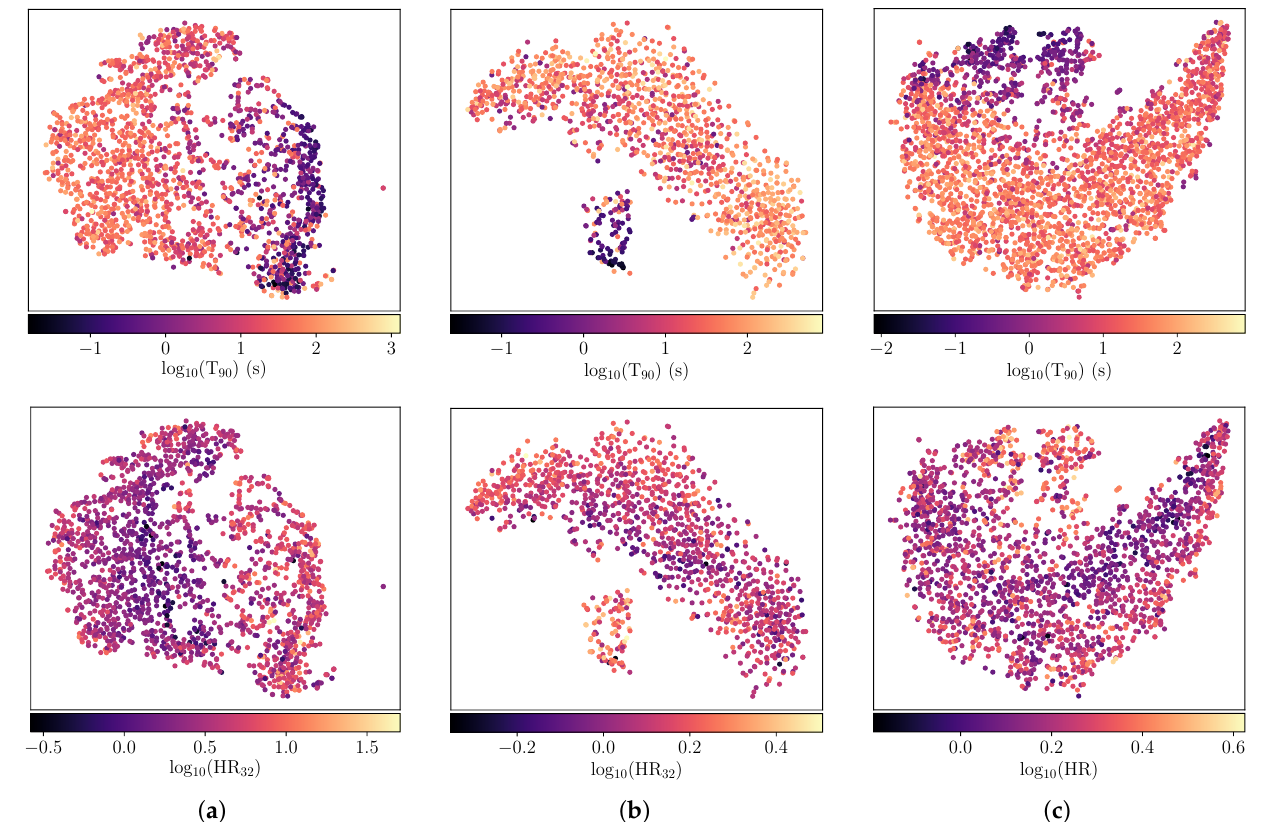
Figure 5. 2D t-SNE representation of the extracted wavelet and PCA features from the first second (T 0 to T 0 + 1.004s) of burst light curves, coloured by burst duration T 90 (top row) and hardness ratio HR 32 (bottom row) for ( a ) BATSE, ( b ) Swift /BAT and ( c ) Fermi /GBM. Hardness ratios (HR 32 ) for Swift /BAT and BATSE are calculated as the ratio of fluence in Band 3 and Band 2. The hardness ratio of Fermi /GBM bursts is defined as the ratio of fluence in the 50–300keV and 10–50keV bands, calculated using the best-fit spectral parameters.